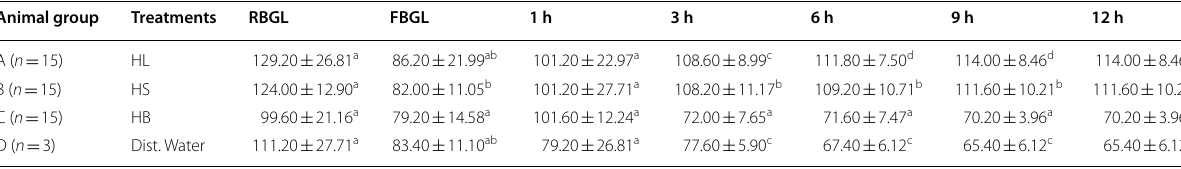
RBGL (Random blood glucose level)-Blood glucose level taken after feeding the mice with equal weight pelletized mice feed for 5 days; FBGL (Fasting blood glucose level)-Blood glucose level taken after 24 h from daytime to overnight fasting Values followed with the same letters (a, b and c) in column are not significantly different ( p > 0.05), values with different letters are significantly different ( p < 0.05) (Tukey’s HSD test at p 0.05) = HB (selected honey samples from beekeepers); HS (selected honey samples from supermarkets); and HL (selected honey samples from local honey parkers